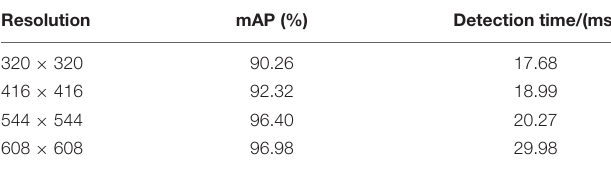
TABLE 2 | Algorithm performance under different